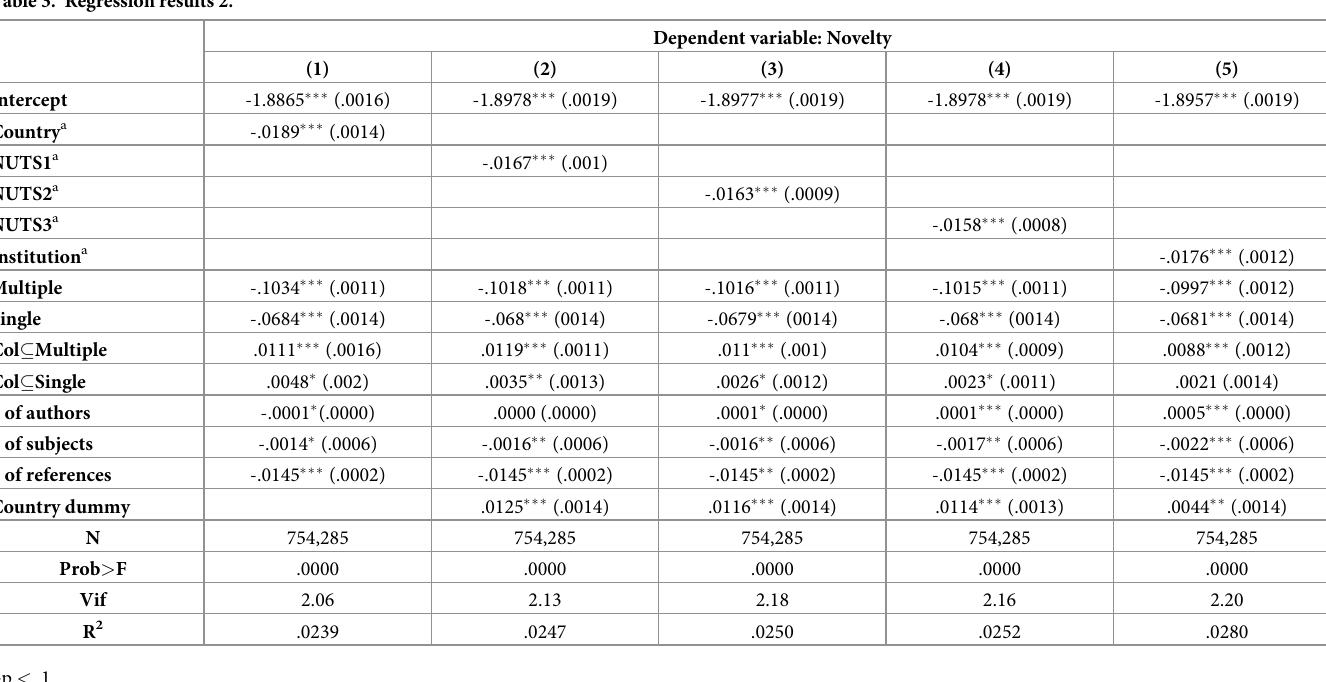
Table 3. Regression results